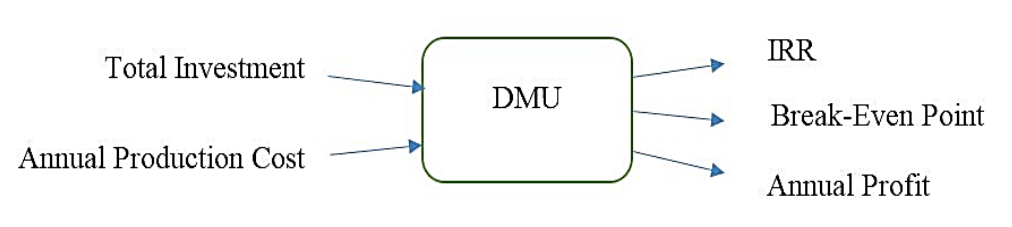
Figure 4. Input and Output